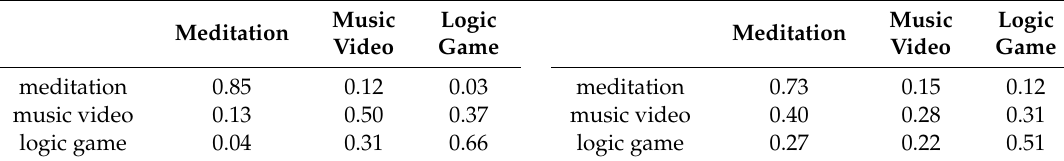
Table 11. Normalized confusion matrix for SVM classifier with linear kernel, value of C = 1, and welch32 feature extraction scheme (left). Normalized confusion matrix for SVM classifier with linear kernel, value of C = 1, and ar16 feature extraction scheme (right).